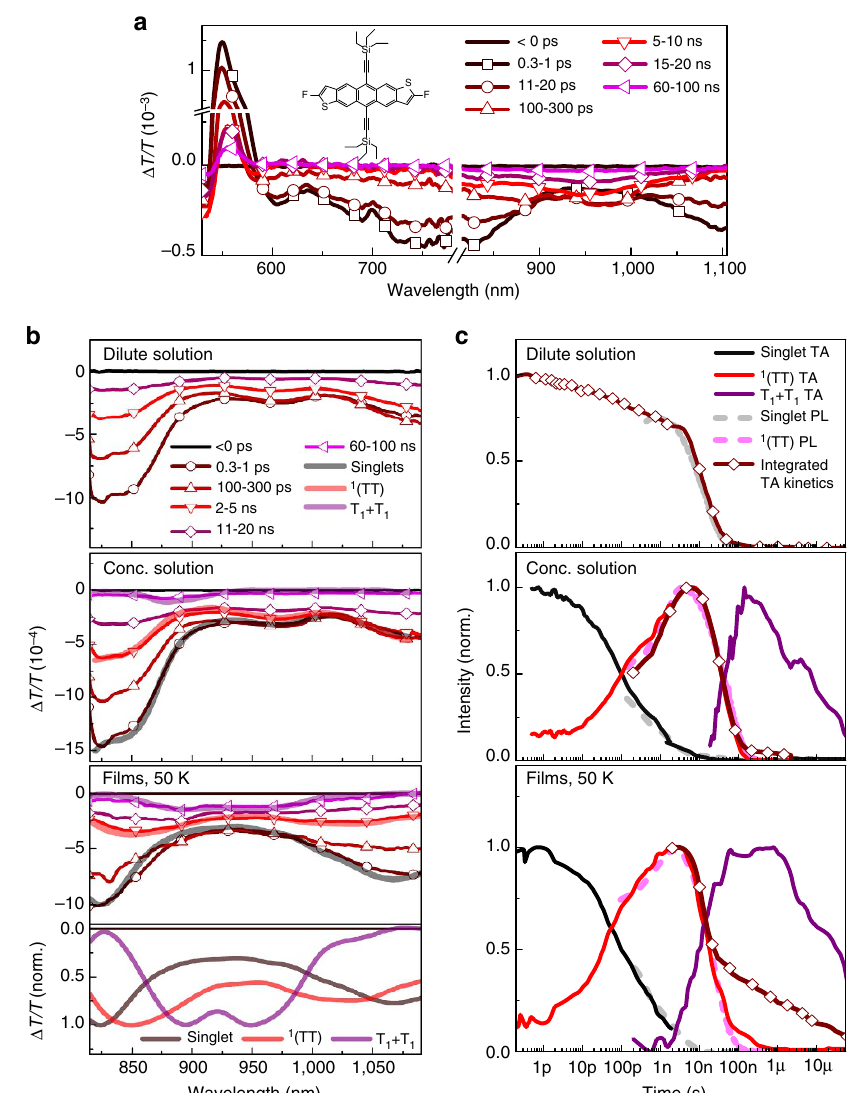
Figure 5 | 1 (TT) absorption in F 2 -TES ADT. ( a ) TA spectra of F 2 -TES ADT films at 300K, averaged over the indicated delay ranges. The initial singlet state (peaks 750–800nm and 4 1,100nm) converts directly into triplet excitons (peak centred at 970nm) over B 300ps, through singlet fission. ( b ) TA spectra of F 2 -TES ADT dilute solution (top, 0.08mM), concentrated solution (middle, 32mM) and thin film measured at 50K (bottom). Extracted spectra (thick lines) closely follow the raw data at different time delays, revealing the presence of substantial triplet population (T 1 þ T 1 ) in concentrated solutions and thin film, as well as a distinct intermediate state 1 (TT). Extracted spectra of the three species in the film at 50K are normalized in the bottom panel for clarity. ( c ) Normalized population kinetics of excited state species extracted from TA maps, exhibiting a sequential progression: singlet (black), 1 (TT) (red) and free triplets (purple). Also plotted are the integrated NIR TA signal (brown, diamonds) and kinetics extracted from the separate transient PL experiment (dashed lines). The agreement of PL and TA population kinetics confirms the same species are observed in both